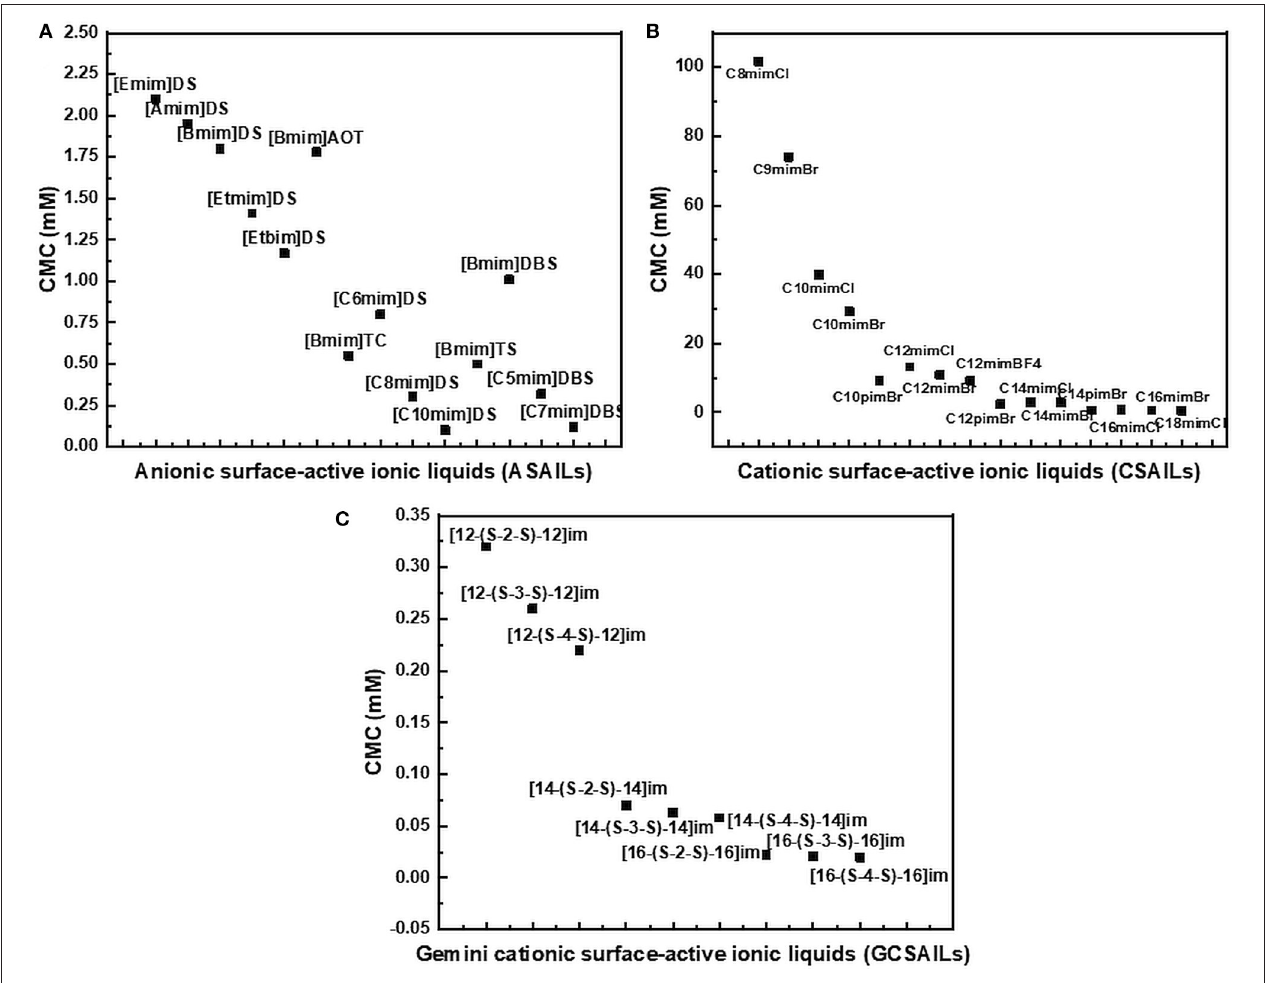
FIGURE 7 | Plot of CMC values of various (A) anionic surface-active ionic liquids (ASAILs) (B) cationic surface-active ionic liquids (CSAILs) (C) Gemini cationic surface-active ionic liquids (GCSAILs).